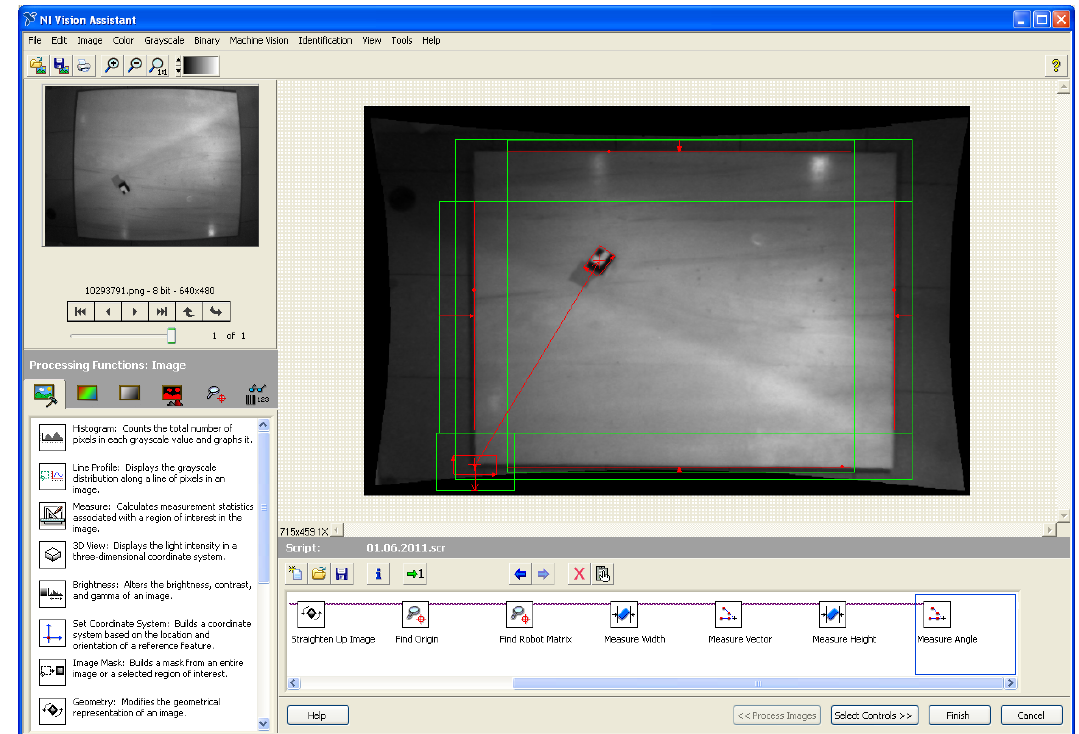
Figure 10. NI Vision Assistant showing the output of the calibration, correction and measurement